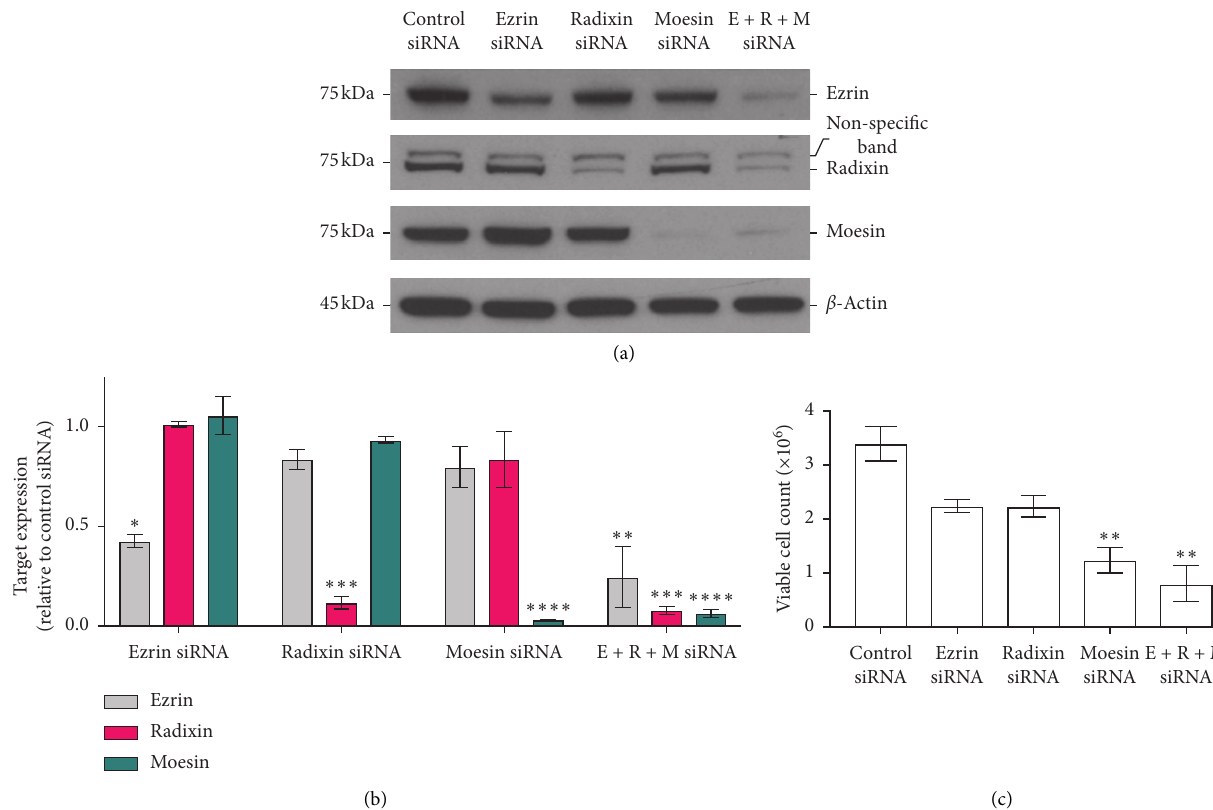
Figure 3: siRNA-mediated interference of ERM proteins reduces RMS cell viability. (a) Representative Western blots showing relative expression of ezrin, radixin, or moesin in RD cells treated with pooled siRNAs against ezrin, radixin, moesin, or all three together. Nontargeting scrambled (control) siRNA was used as a negative control for target protein expression, and β -actin was used as a loading control. (b) Quantification of ezrin, radixin, and moesin expression in cells treated with siRNA against ERM proteins relative to the corresponding target expression in control siRNA-treated cells. Expression is plotted as a function of relative band intensities determined using ImageJ software. (c) Viable cell counts as determined by trypan blue staining 96h after treatment of RD cells with siRNA against ERM proteins or nontargeting control siRNA. Bars represent mean ± SEM, and asterisks represent a significant difference between control siRNA treatment group and ERM siRNA treatment groups as determined by one-way ANOVA with Dunnett’s multiple comparisons tests ( ∗ p < 0 . 05, ∗∗ p < 0 . 005, ∗∗∗ p < 0 . 0005, and p < 0 . 0001 � ∗∗∗∗ ). All data are representative of two independent